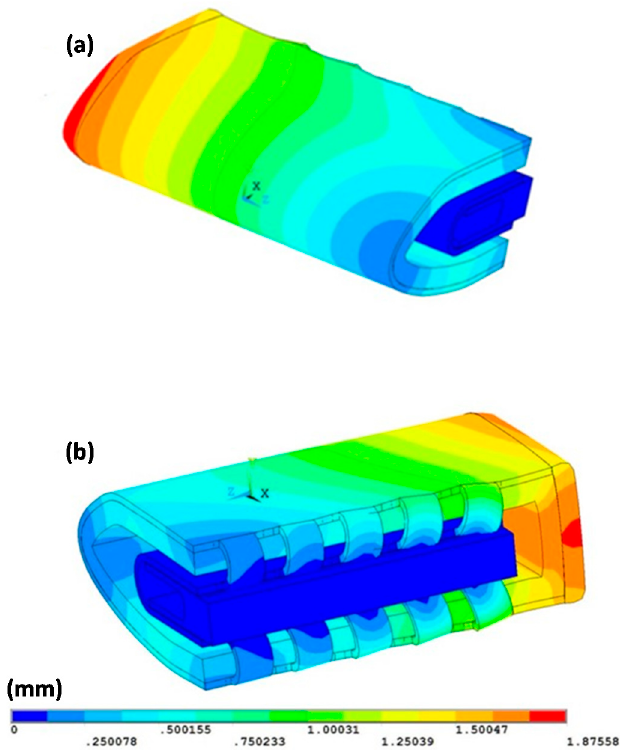
Figure 10. Displacements (magnitude)—Global coarse solid model: ( a ) front view; ( b ) rear view. Amplification factor: 7.